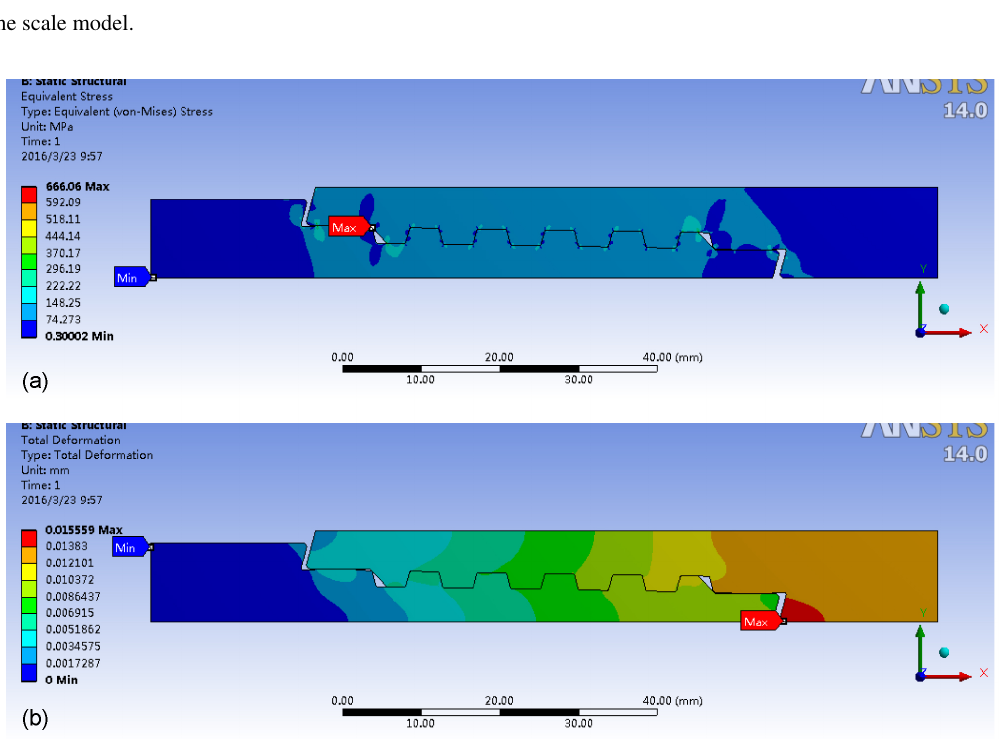
Figure 11. Connection state under optimum makeup torque: (a) stress under optimum makeup torque and (b) strain under optimum makeup